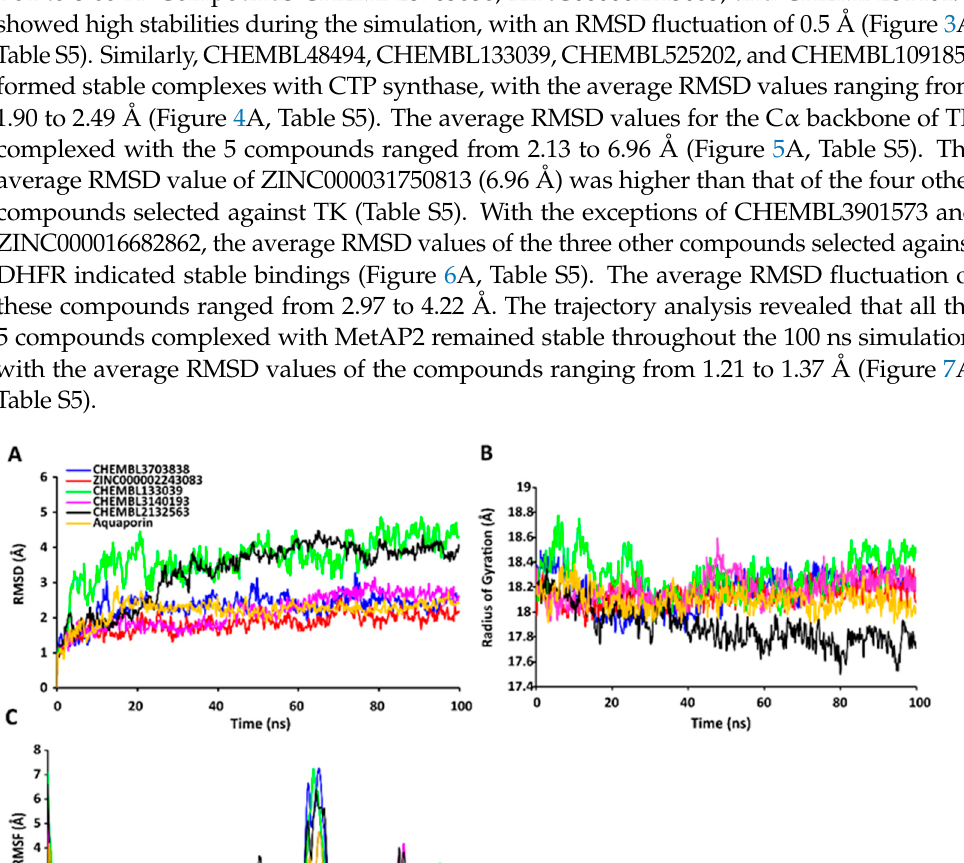
Figure 4. Stabilities of the protein–ligand complexes during 100 ns MD simulations. ( A ) RMSD val- ues of the protein–ligand complexes fitted to the C α backbone of CTP synthase. The x -axis depicts the duration of simulation, while the y -axis represents the RMSD. ( B ) Analysis of the Rg values of the protein–ligand complexes. The x -axis depicts the duration of simulation, while the y -axis repre- sents the deviations in Rg. ( C ) The RMSF values of the C α backbone of CTP synthase. The x -axis depicts the total number of residues, while the y -axis represents the RMSF in Å. The different lig- ands complexed with CTP synthase are represented by lines of different colors.